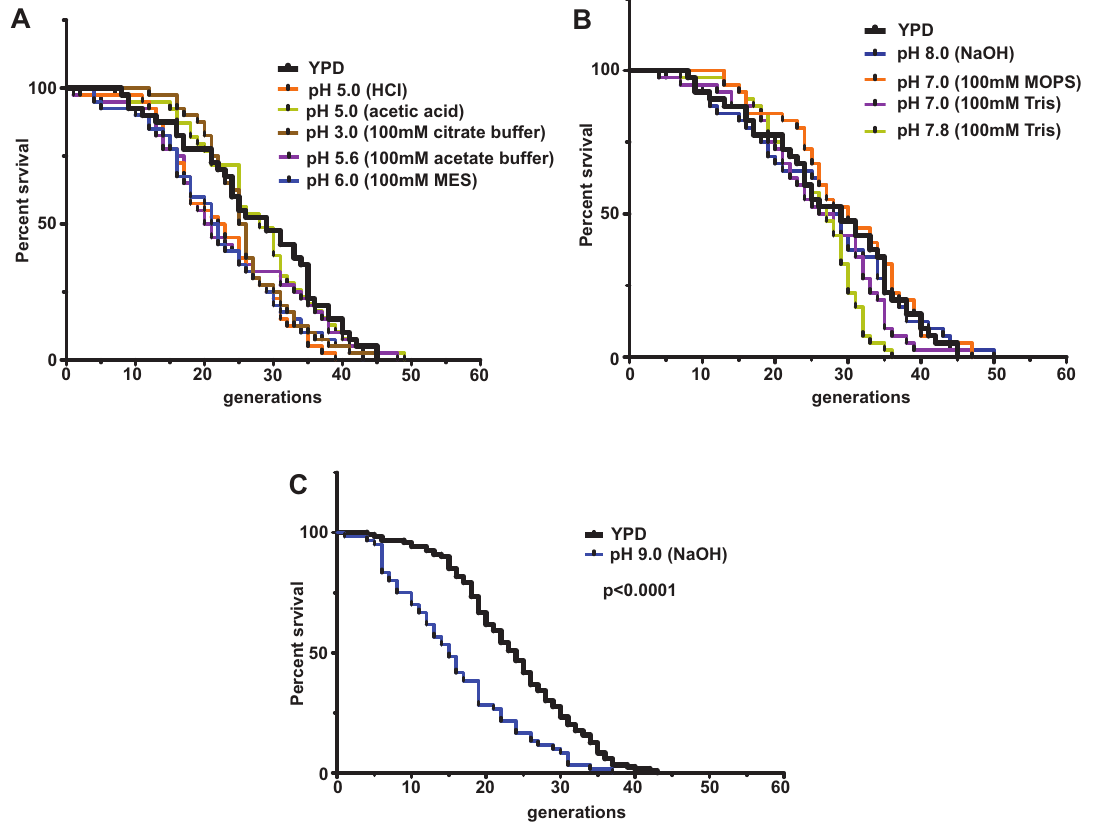
Figure 1. Replicative lifespans with pH adjusted to 7–8 by buffering or NaOH ( A ), or pH 6.0 or below by acids or buffers ( B ) and to pH 9.0 by NaOH ( C